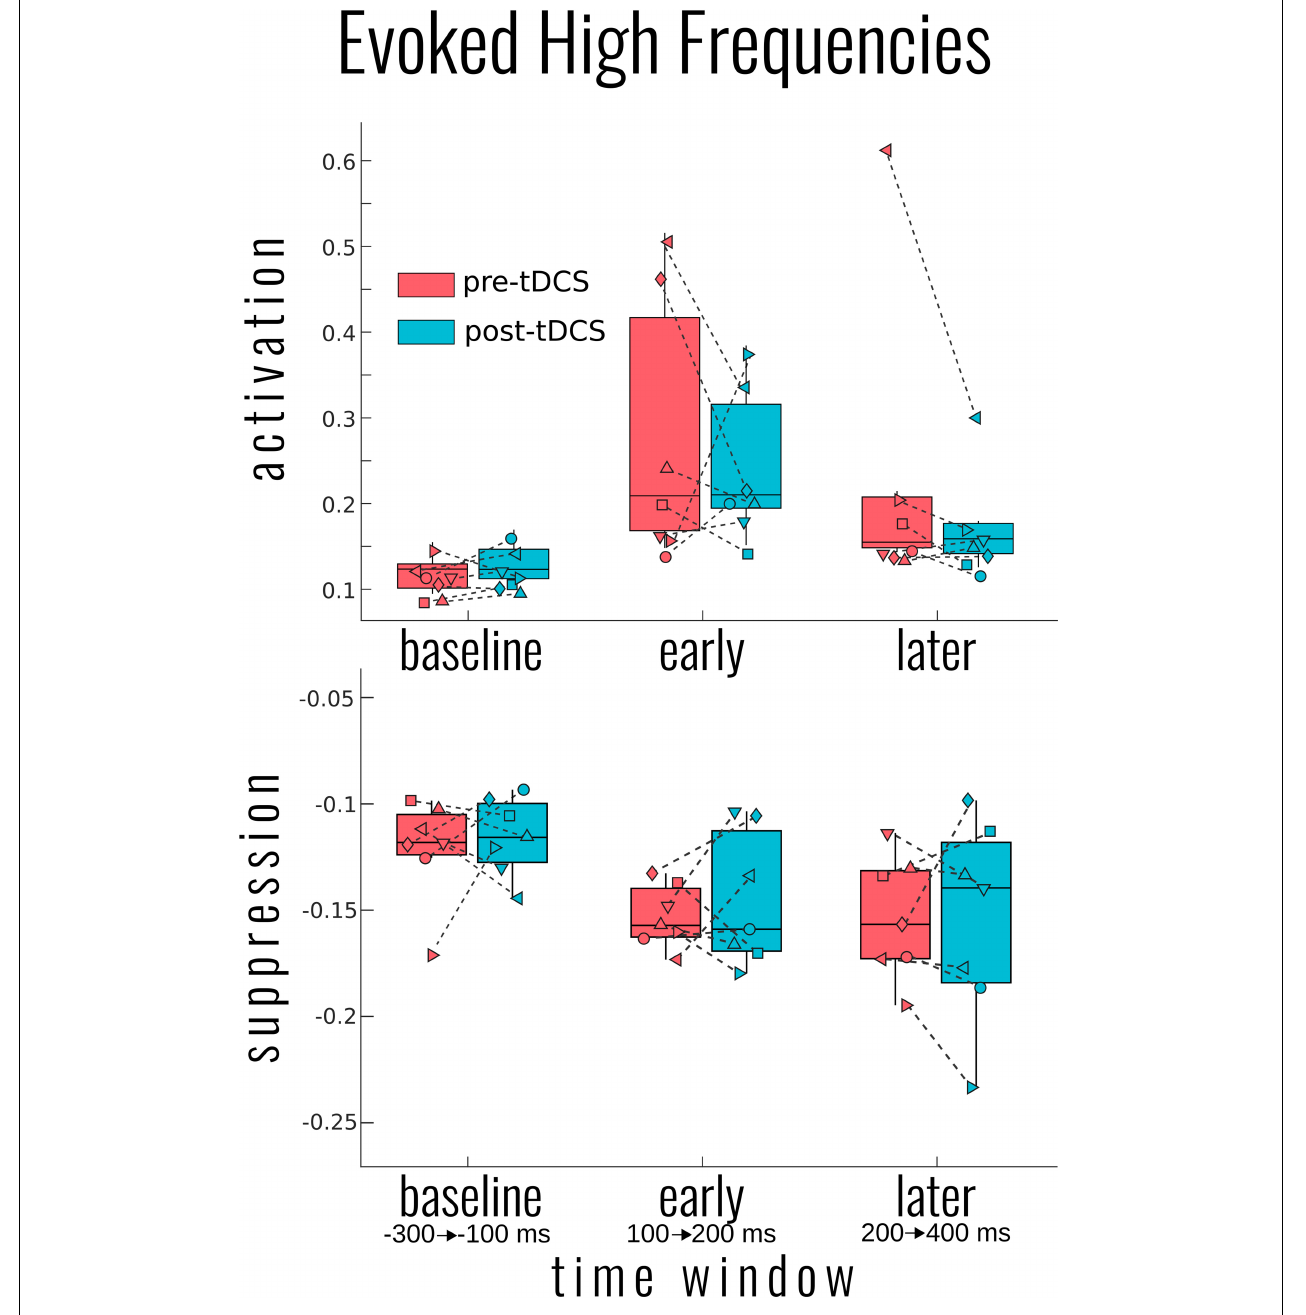
FIGURE 3 | Group results for the effect of transcranial magnetic stimulation (tDCS) on the evoked high-frequency power. Activation ( top ) and suppression ( bottom ) of high frequencies (20–50 Hz) for each participant and group average in box plots as measured by the bottom and top 5% of the event-related spectral perturbation over each of the indicated time windows. No significant differences in pre- to post-tDCS were found for either high-frequency measure. Each patient’s disorders of consciousness (DOC) classification can be found in Figure 2 above.